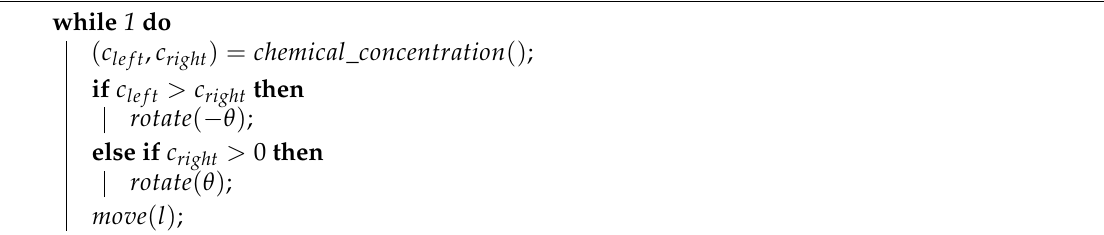
Algorithm 2: Pseudocode of a generic gradient-following